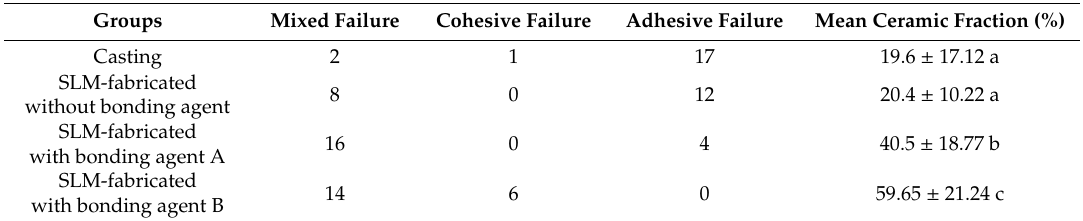
Table 5. Results of failure mode analysis.